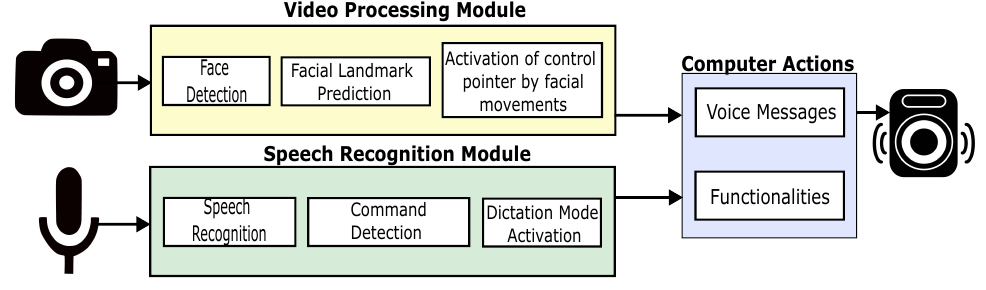
Figure 1. EMKEY block